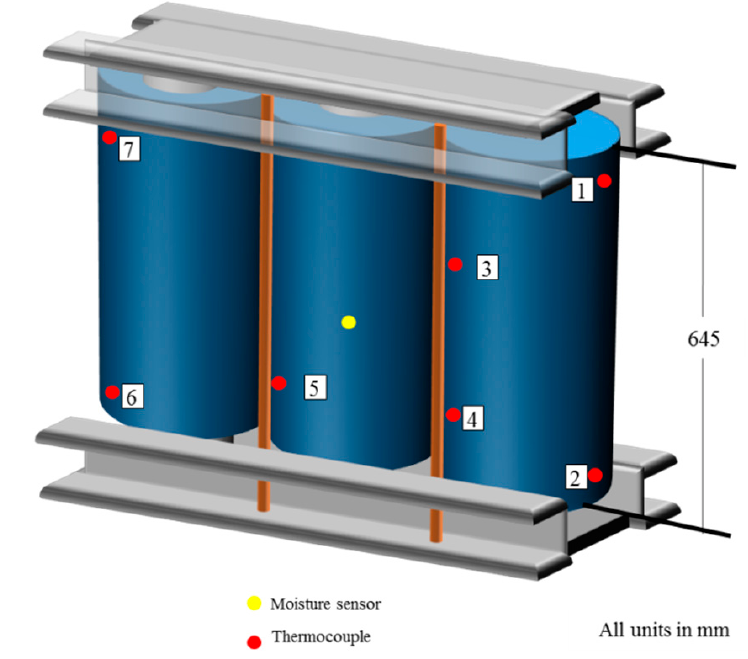
Figure 2. Location of the installed temperature and moisture sensors.